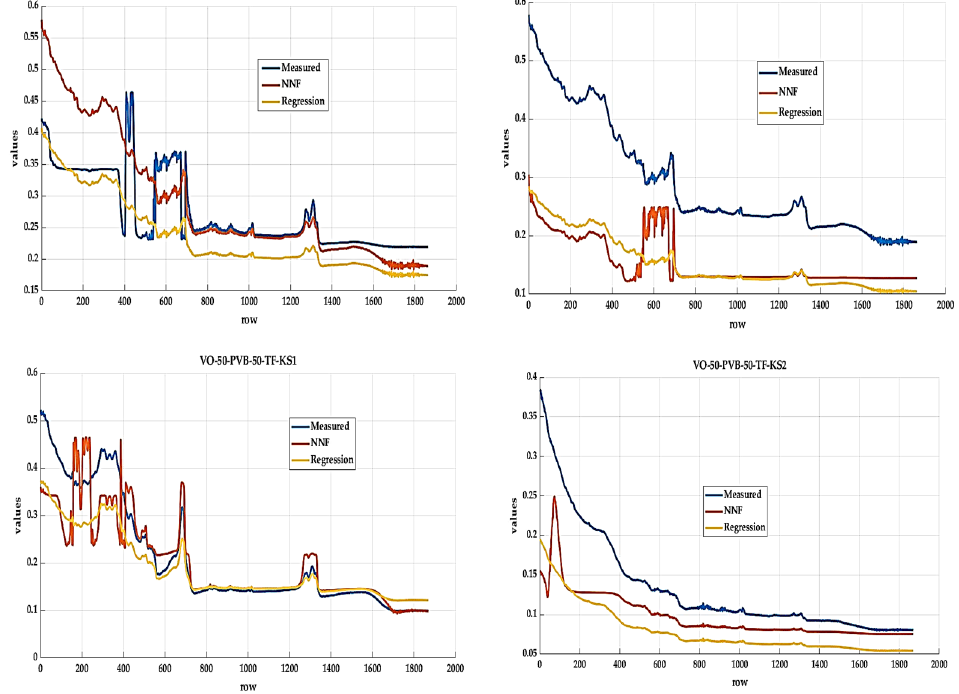
Figure 9. Graphic representation of the proposed models [authors own processing].